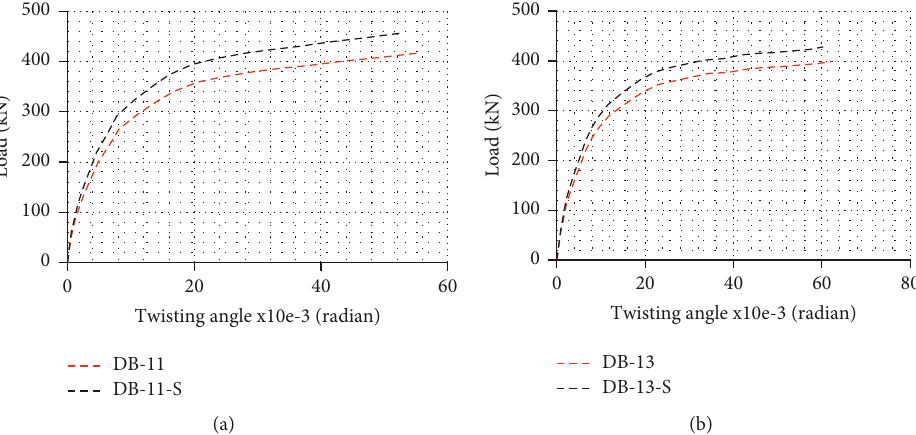
Figure 15: Load-twisting angle curves with different spacing of vertical shear reinforcement (100 mm and 50 mm). (a) Beam with L/D and L/ R ratios equal to 3 and 1.05, respectively, and (b) beam with L/D and L/R ratios equal to 3 and 1.57,